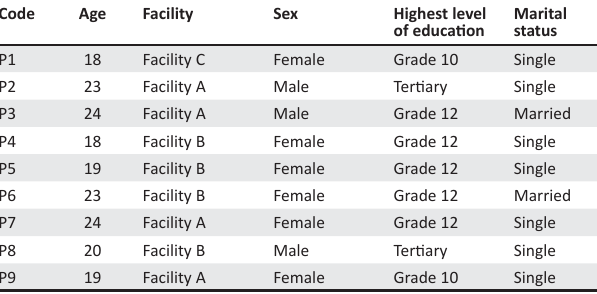
TABLE 1: Participants: Young adults.